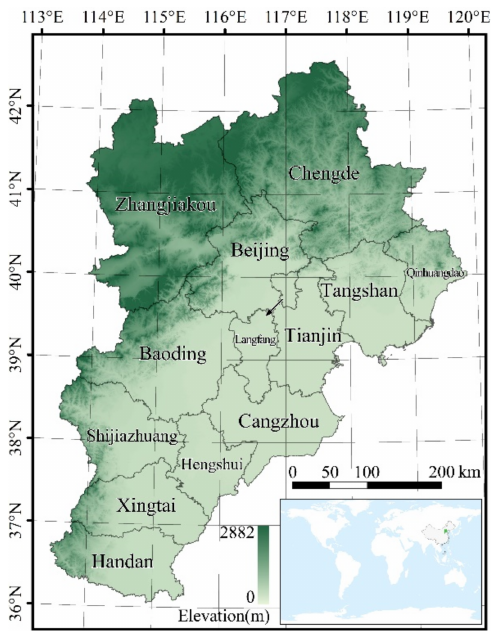
Figure 1. Geographical location (113 ◦ 27 (cid:48) –119 ◦ 51 (cid:48) E, 36 ◦ 05 (cid:48) –42 ◦ 40 (cid:48) N) of the study